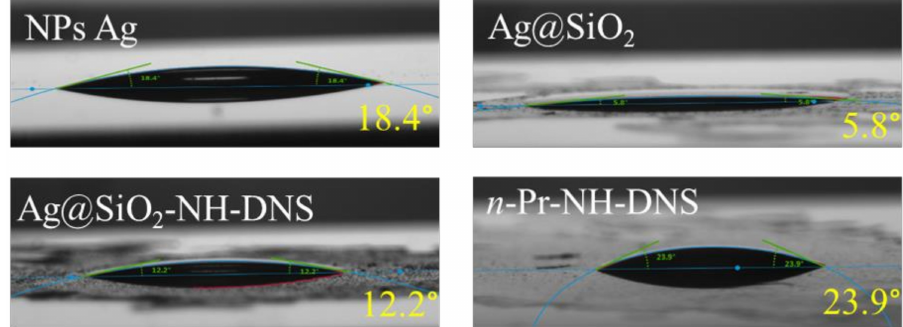
Figure 3. Photographs showing water contact angle measurement results for the measured